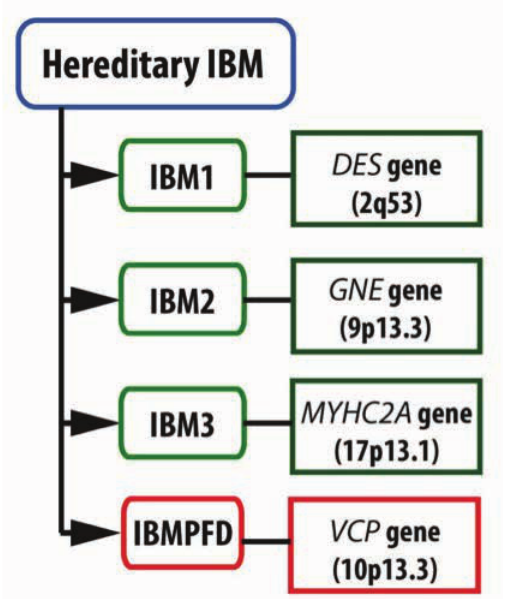
Figure 1. The genetic features of the three types of hereditary inclusion body myopathy (IBM) and the IBM with early-onset Paget disease and frontotemporal dementia (IBMPFD). There are 4 types of familial IBM. Types 1, 3 and IBMPFD are autosomal dominant whereas IBM2 is autosomal recessive disease (for details see